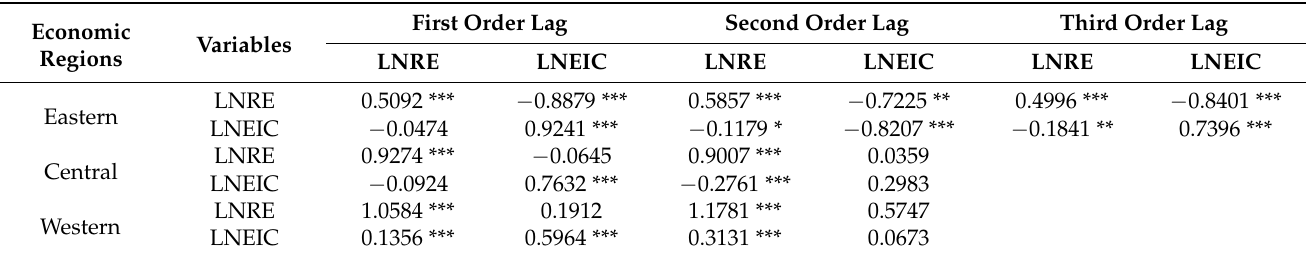
Table 5. Estimation results of VAR models for the three economic